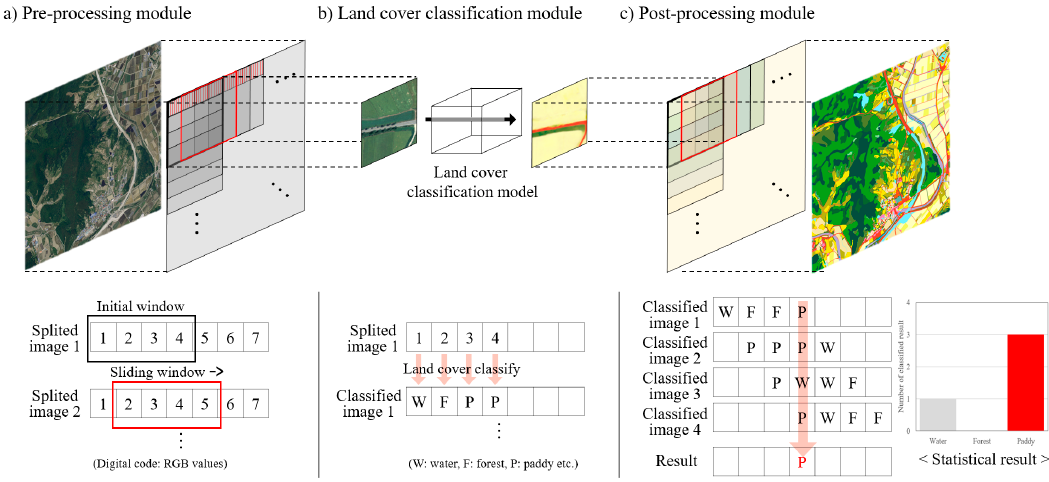
Figure 1. Conceptual schematic of the land cover classification model. ( a ) Pre-processing module, ( b ) Land cover classification module, ( c ) Post-processing module.